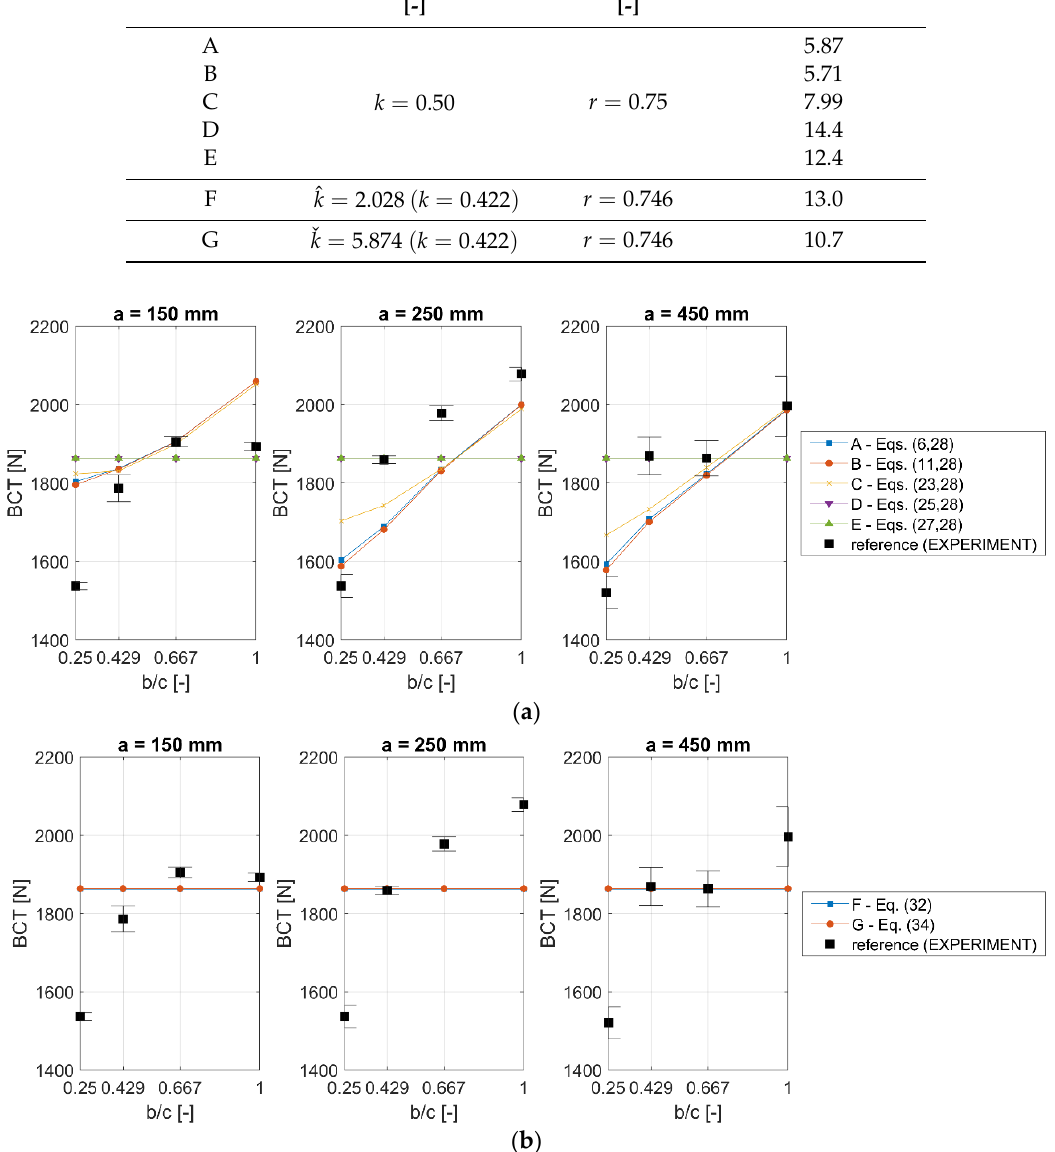
Figure 5. Compressive strength of simple flap boxes with different heights: 150 mm, 250 mm and 450 mm, computed for optimal ratios of 𝑘 , 𝑟 , 𝑘̂ and 𝑘̌ for: ( a ) cases A–E and ( b ) cases F–G (see Table 4).